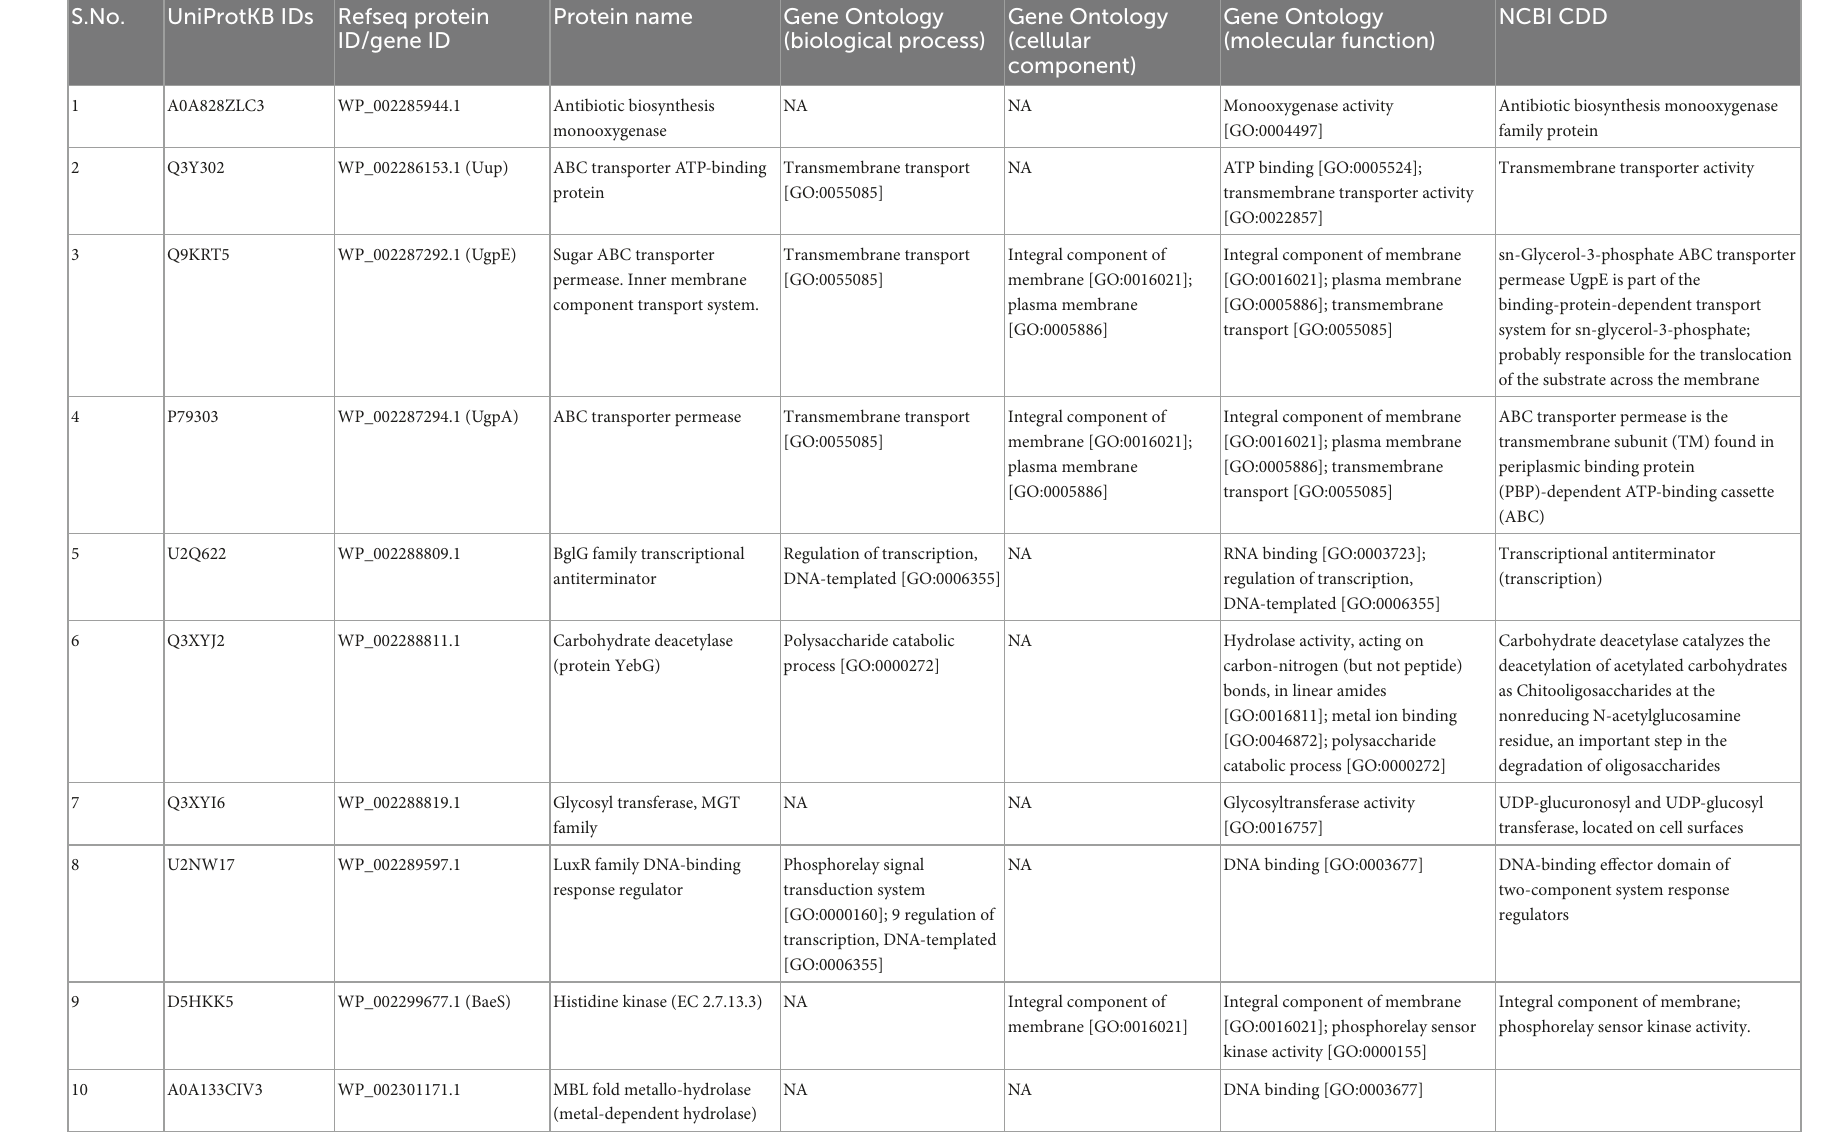
TABLE 3 Details of the proteins discerned through COG-clustering as exclusive to hypo-cholesterolemic probiotics E. faecium LR13 and WEAF3.